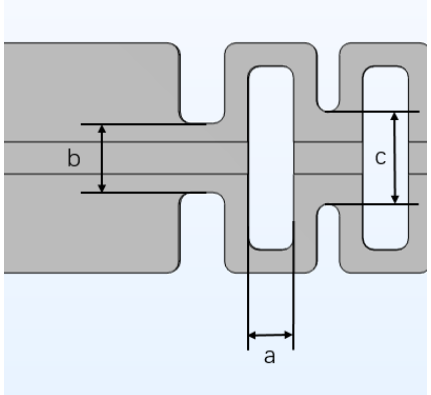
Figure 6. Parameters of the strain amplification area of the sensor package.